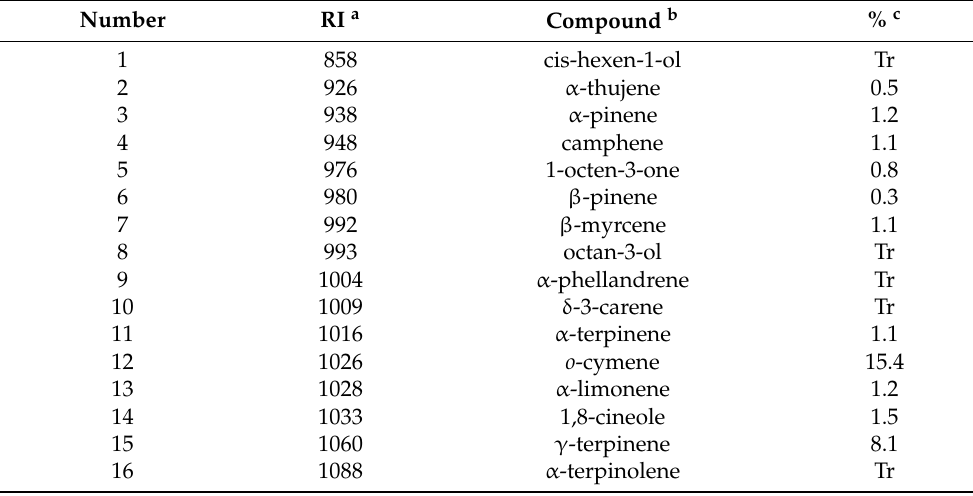
Table 1. Chemical composition of essential oil of Thymus serpyllum